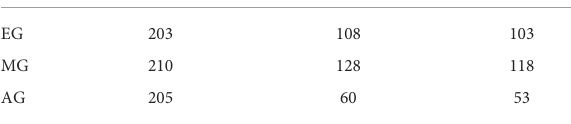
TABLE 5 Descriptive data of CF and learners’ responses to